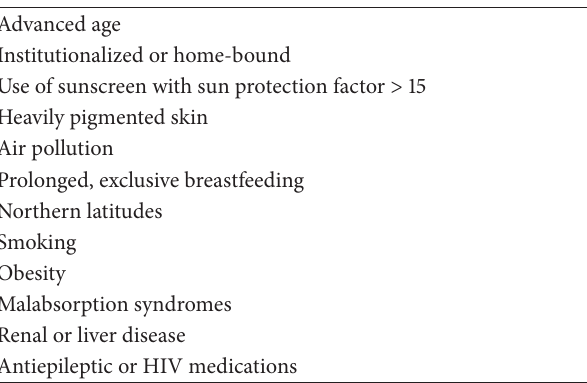
Table 3: Risk factors for developing vitamin D